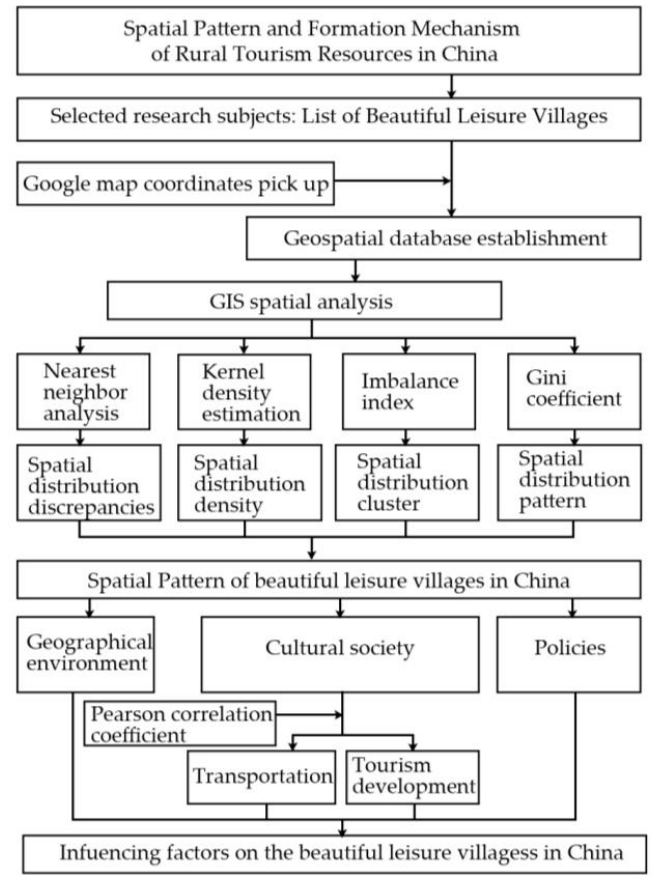
Figure 3. Flow diagram of research ideas.